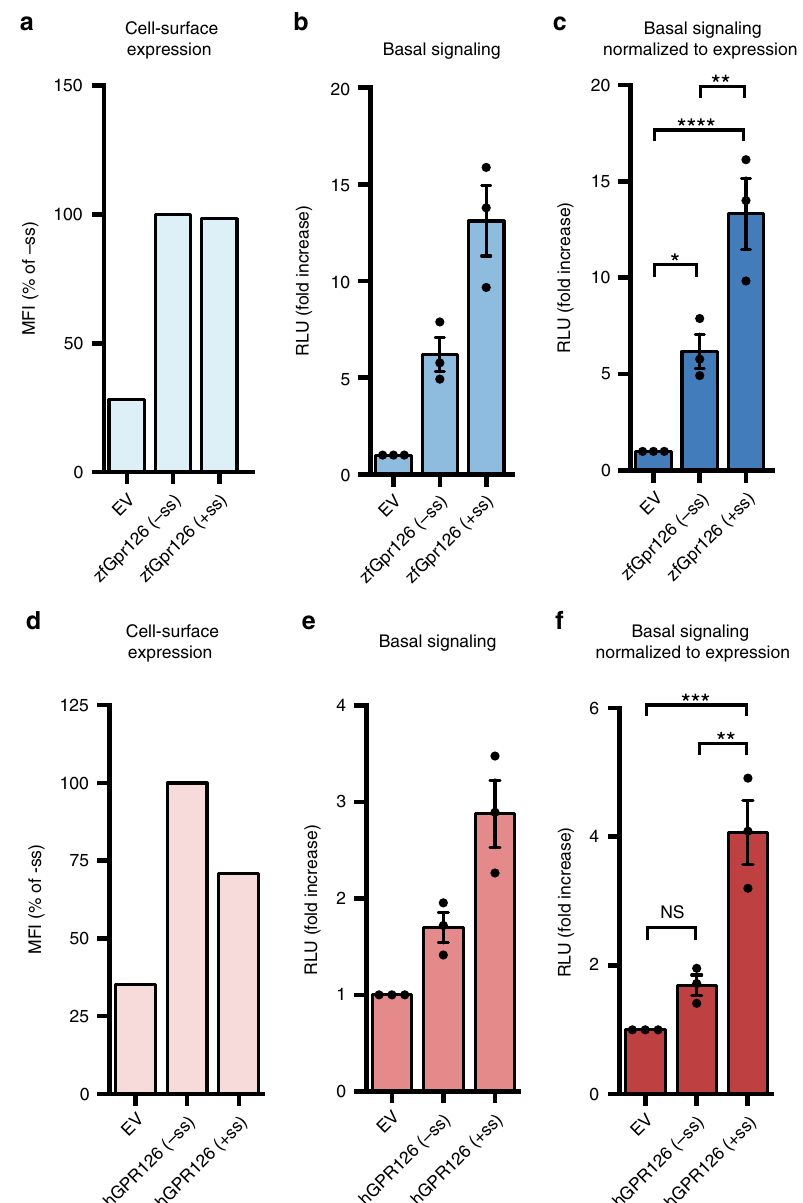
Fig. 4 Alternative splice isoforms of Gpr126 modulate receptor signaling. a Cell-surface expression levels for empty vector (EV), zebra fi sh Gpr126 splice isoforms, measured using fl ow cytometry to detect binding of anti-FLAG antibody to cells expressing FLAG-tagged Gpr126. The Gpr126 cell-surface expression levels are normalized to the control EV signal. Data are shown as MFI (mean fl uorescence intensity). Error bars are not shown because expression levels are presented as median fl uorescence intensities of 10,000 cells for each population of transfected cells, for a single fl ow cytometry experiment representative of at least three independent experiments. b Basal signaling measured by the cAMP signaling assay. Data are shown as fold increase over EV of RLU (relative luminescence units). c Basal cAMP signaling normalized to cell-surface expression. ns, P > 0.05; * P ≤ 0.05; ** P ≤ 0.01; *** P ≤ 0.001; **** P ≤ 0.0001; by one-way ANOVA and Tukey ’ s multiple comparisons test. Data in b and c are presented as mean ± SEM, n = 3, and are representative of at least three independent experiments. d – f Same as a – c but for human GPR126 splice isoforms. Source data are provided as a Source Data fi